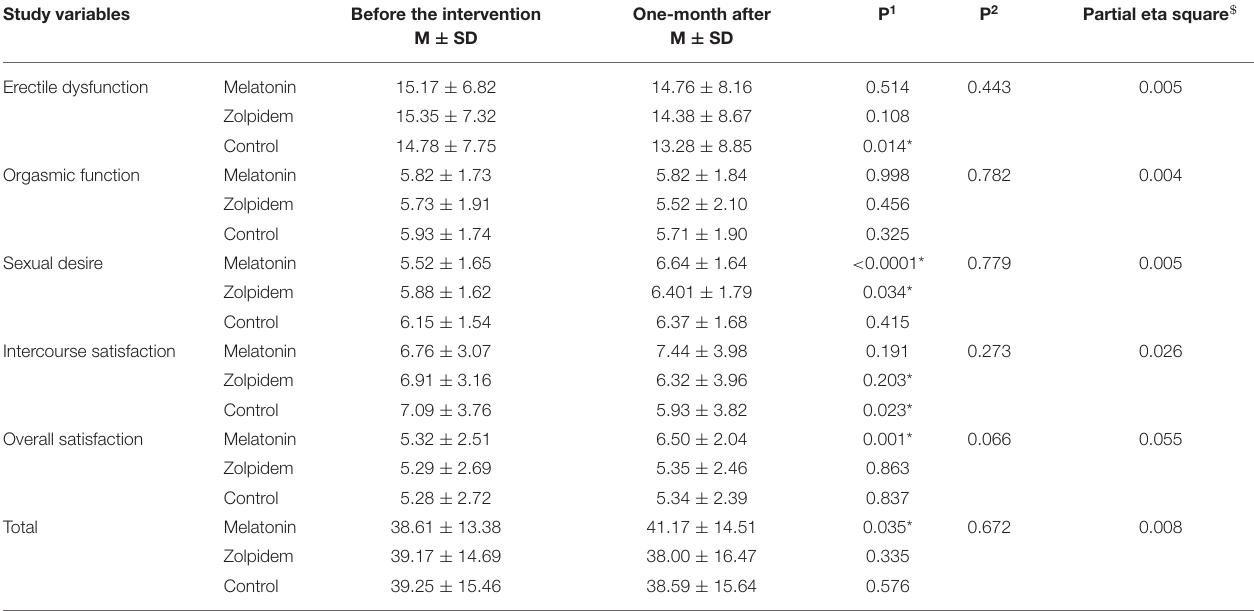
TABLE 2 | Comparison of changes in the scores for sexual function domains in the three groups. Study